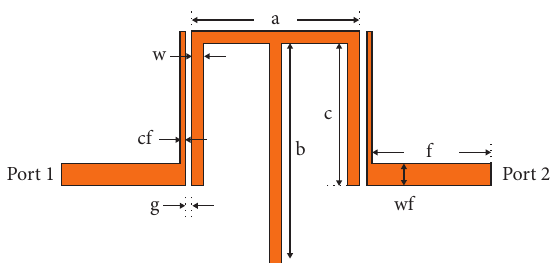
Figure 4: Schematic structure of the dual-mode microstrip res- onator with input/output coupled feed.